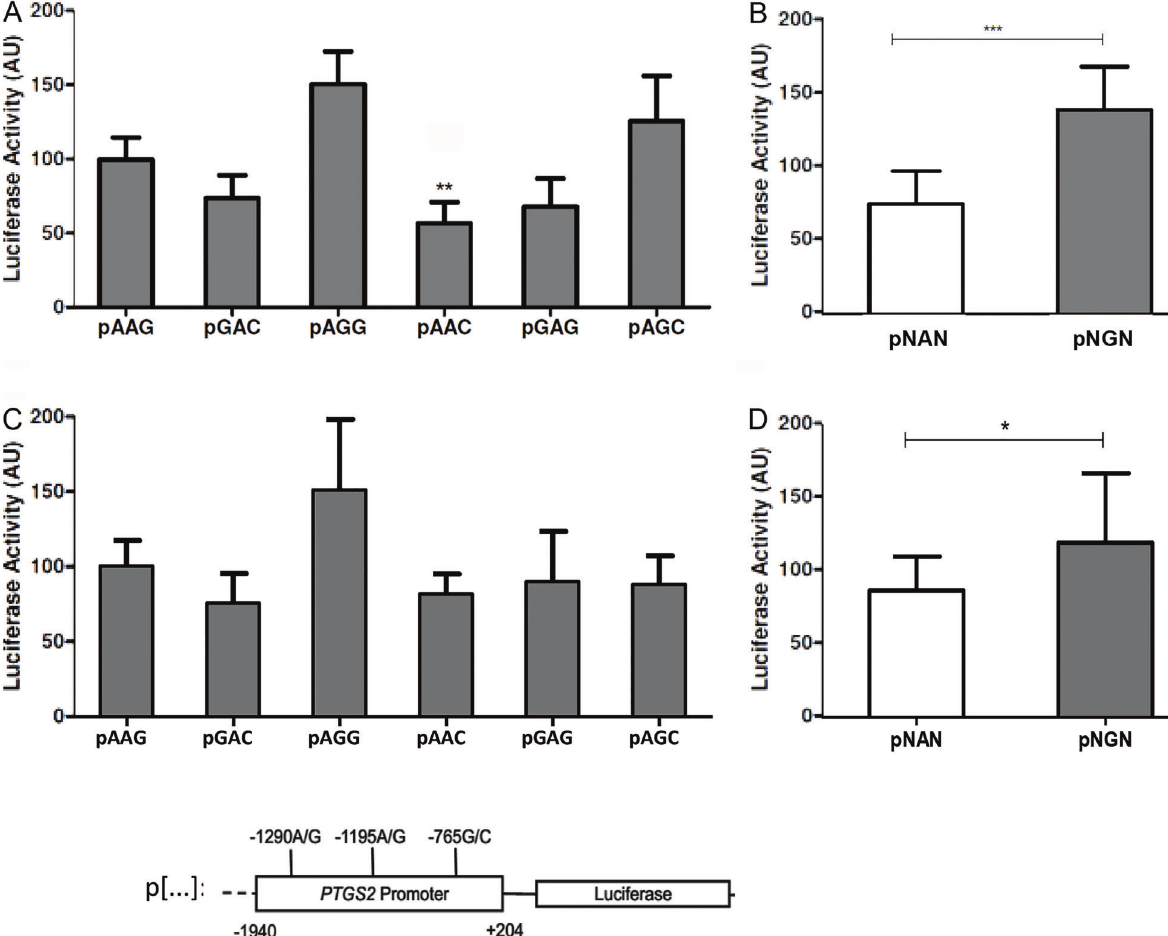
Figure 1. Luciferase activity of constructs containing the promoter region of the PTGS2 gene in MCF-7 cells ( panels A and B ) or in HEK293FT cells (panels C and D ). The results are depicted for each construct ( panels A and C ) or in relation to rs689466 A/G allele ( panels B and D ), combining data obtained with constructs pAAG, pGAC, pAAC and pGAG (pNAN) or with pAGG and pAGC (pNGN). Data are reported as the fold variation of luciferase activity in relation to pAAG, and are the means ± SD from at least 2 independent transfection experiments, comprising 12 replicates. Statistical analyses were conducted comparing each construct to pAAG ( panels A and C ), or comparing pNGN versus pNAN ( panels B and D ). *P o 0.05, **P o 0.001, ***P o 0.0001 (Mann-Whitney U-test and Kruskal- Wallis test with Dunn ’ s